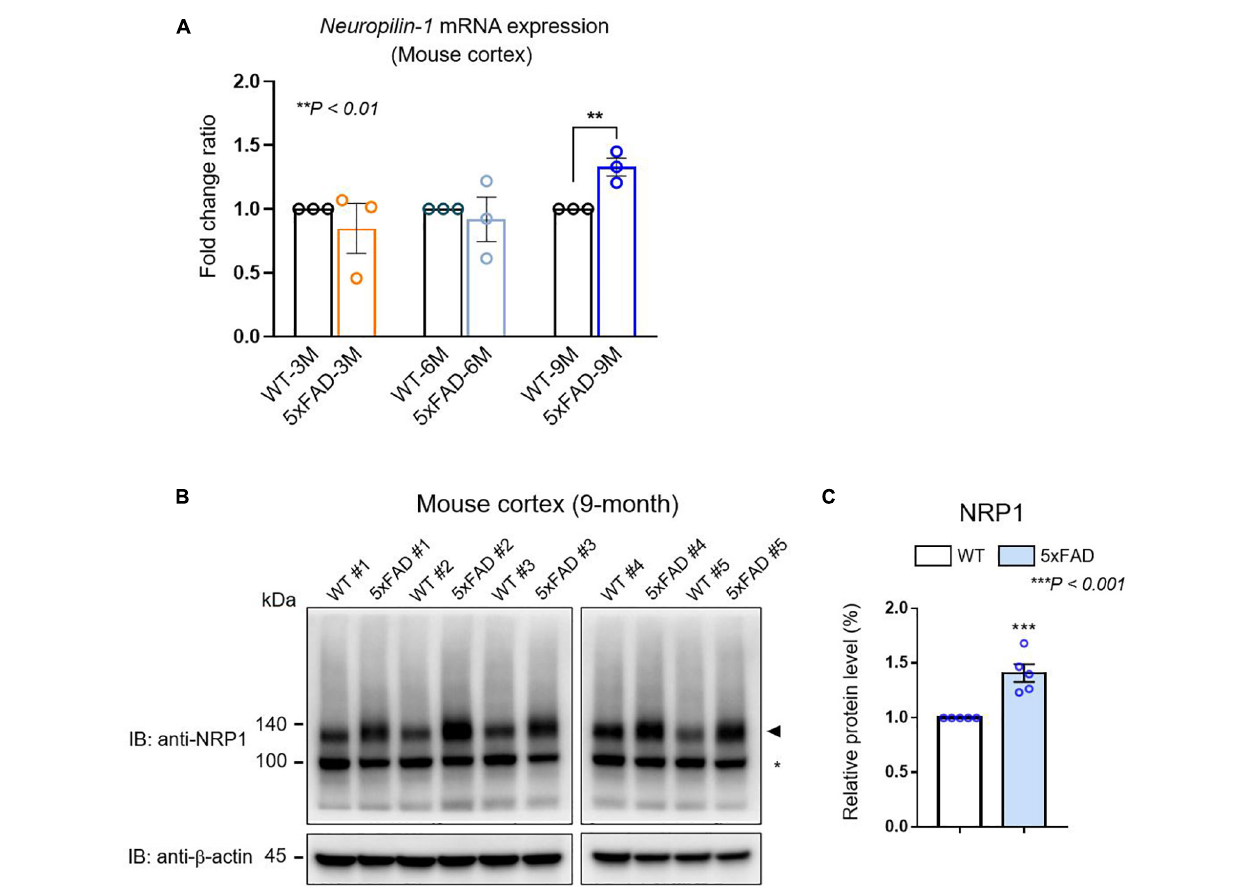
FIGURE 2 | The expression of NRP1 in mouse AD brain. (A) RT-qPCR analysis showing the Nrp1 mRNA expression levels in the cortex of WT and 5 × FAD mice. Nrp1 mRNA expression is significantly increased in 9-month-old 5 × FAD cortex compared with that in WT cortex. No significant differences are observed in the early disease stages of 5 × FAD mice (3 and 6 months). The data are shown as the mean ± standard error of the mean (SEM) from n = 3 mice per group; statistical differences were assessed using unpaired t -test. (B) Representative Western blot analyzing the NRP1 protein levels in 5 × FAD brains. Endogenous NRP1 is highly expressed in 9-month-old 5 × FAD brains compared with that in the WT brain. β -actin was used as a loading control. The arrowhead indicates the NRP1 protein, and the asterisk indicates a non-specific band ( n = 5 mice per group). (C) NRP1 Western blot band intensity measured by ImageJ 1.50i software ( n = 5 mice per group). Statistical differences were assessed using unpaired t